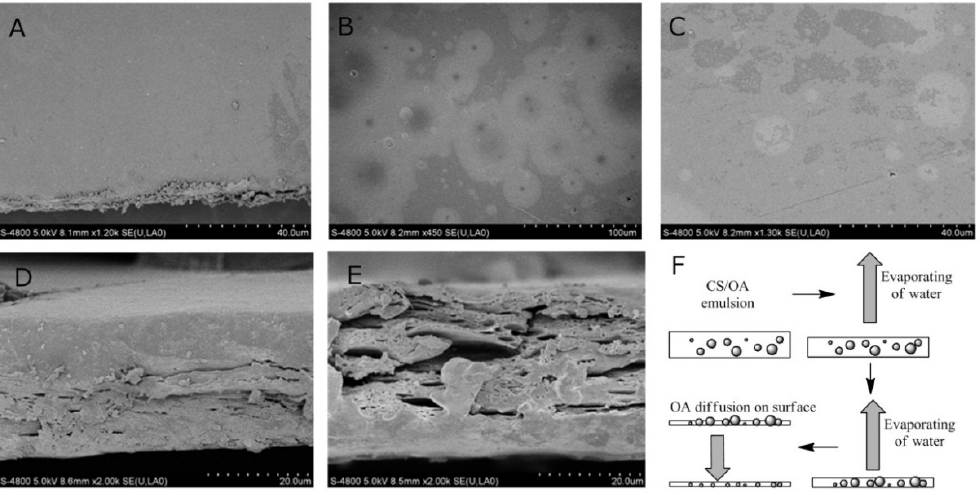
Figure 2. Surface appearance and cross-section appearance of films; surface of CS film ( A ); CS + 25% OA film ( B ); CS + 25% OA film ( C ) and cross section of CS film ( D ); CS + 25% OA film ( E ); and process of CS-OA film formation during water evaporating ( F